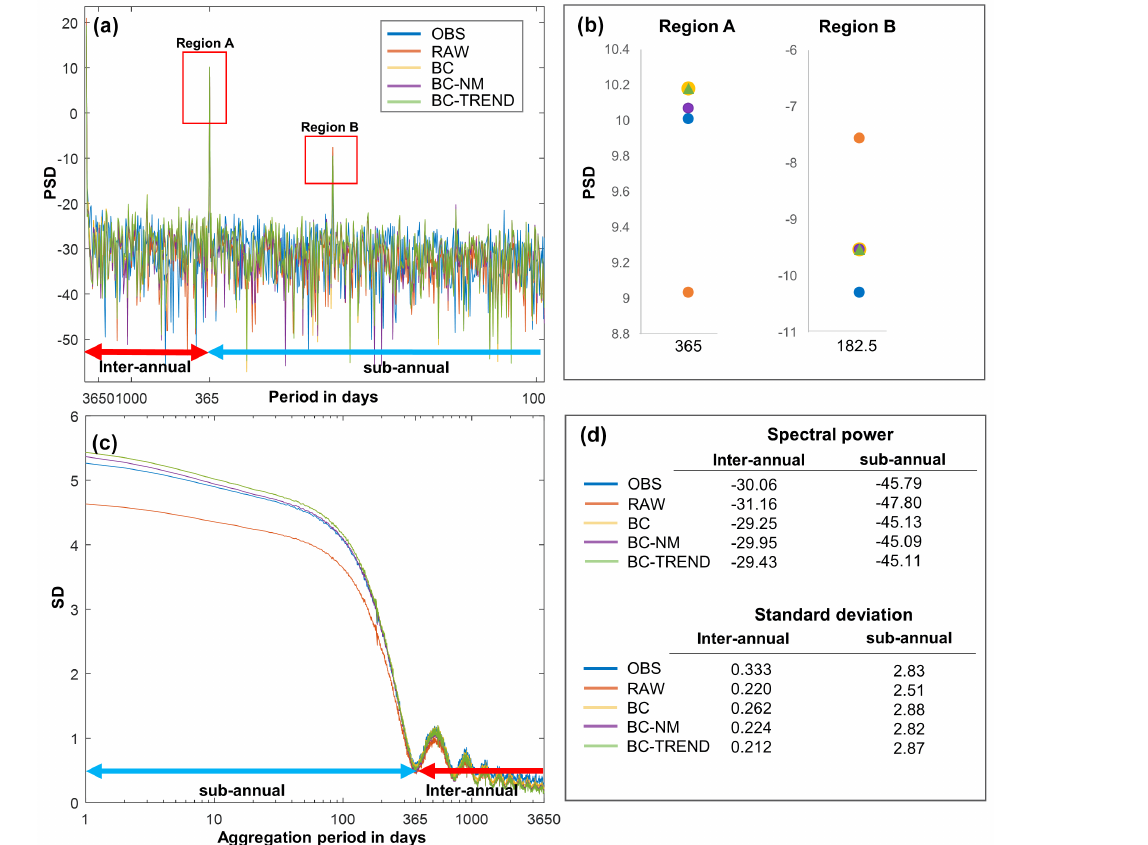
Figure 6. Power spectral density of temperature (a) and high-power regions of annual and half-year periods (b) . (c) Standard deviation of temperature aggregates between 1 and 10957 days (horizontal axis visible between 1 day and 10 years). (d) The inter-annual and sub-annual periods’ average (denoted with red and cyan arrows respectively) spectral power (a) and standard deviation (c)